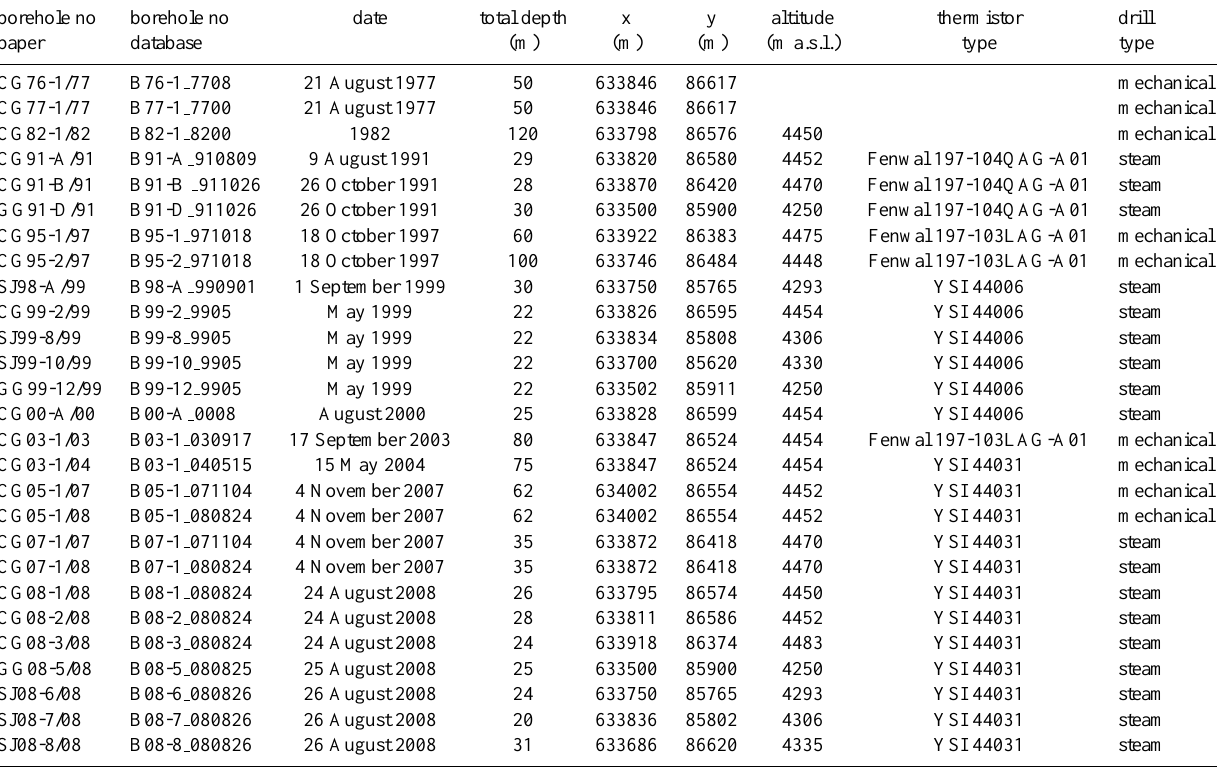
Table 1. Information about all boreholes mentioned in this study with measurement number, date and max. measurement depth, location and altitude of the boreholes, thermistors used and borehole drilling